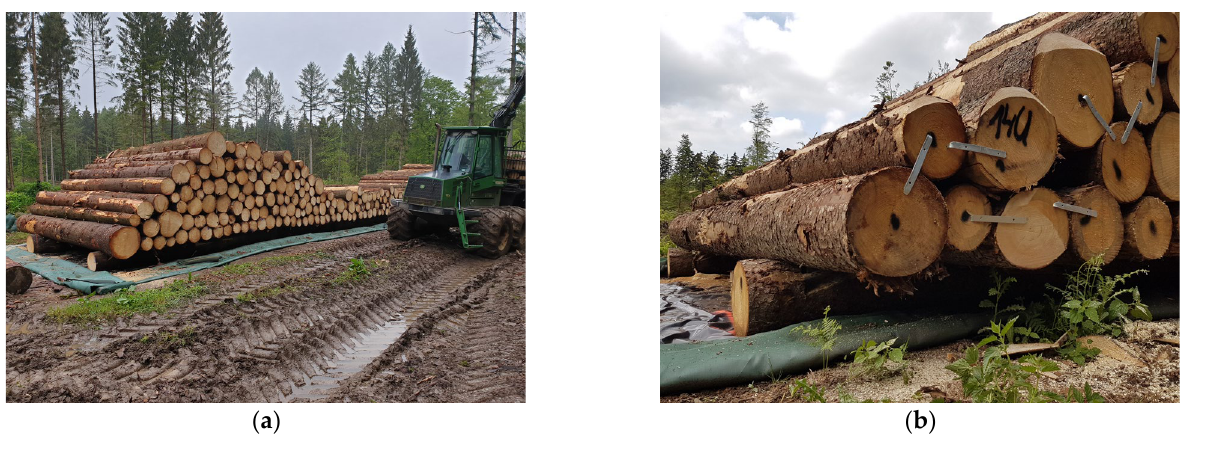
Figure 2. Installation of foil storage in the forest district of Dassel, Lower Saxony, Germany, according to the Baden-Württemberg method. ( a ) Piling of Norway spruce logs on a ground foil and lying support logs; ( b ) rounded cut edges and fixation of the sections with construction clips (Photo: J. Hartje, 2021).